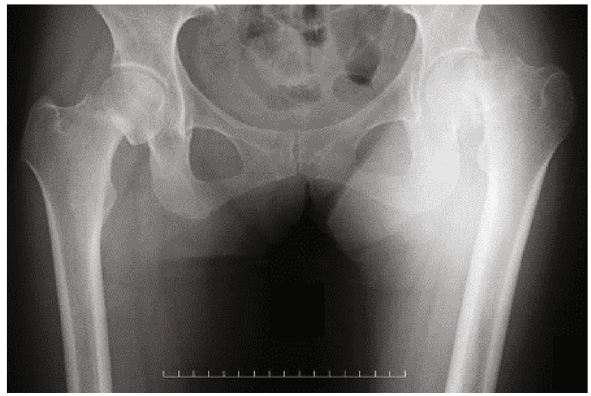
Figure 4: Radiograph of the hip 12 months after